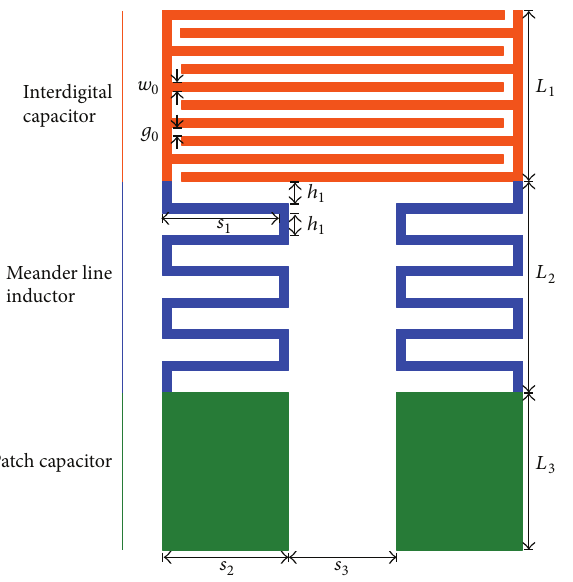
Figure 3: Microstrip implementation of the improved CRLH structure.